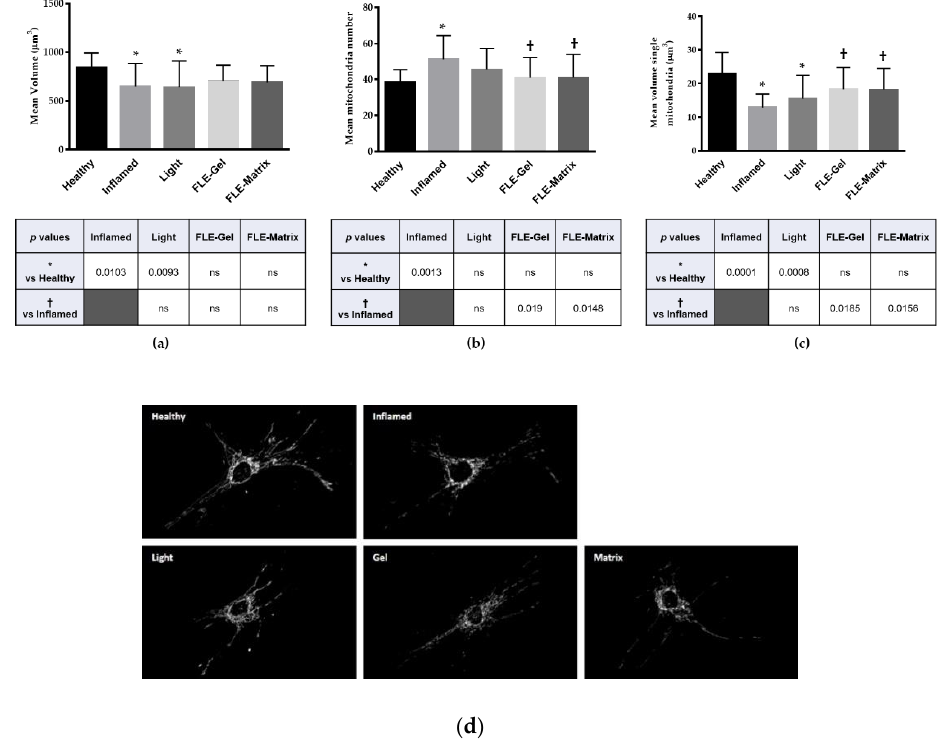
Figure 1. Quantification of mitochondrial network 30-min post-treatment. After deconvolution, images were 3D reconstructed and the mitochondrial network was evaluated by automated estimation of ( a ) volume of the entire mitochondrial network per single cell, ( b ) number of mitochondria per single cell, and ( c ) volume of single mitochondrion. Data are expressed as mean ± SD. Multi comparison statistical analysis were performed by using one - way analysis of variance (ANOVA). T tests were performed on all pairwise comparisons between group means. * p < 0.05 from Healthy human dermal fibroblasts (HDFs), † < 0.05 from Inflamed human dermal fibroblasts (HDFs), ns = not significant. ( d ) Representative images. FLE: fluorescent light energy.